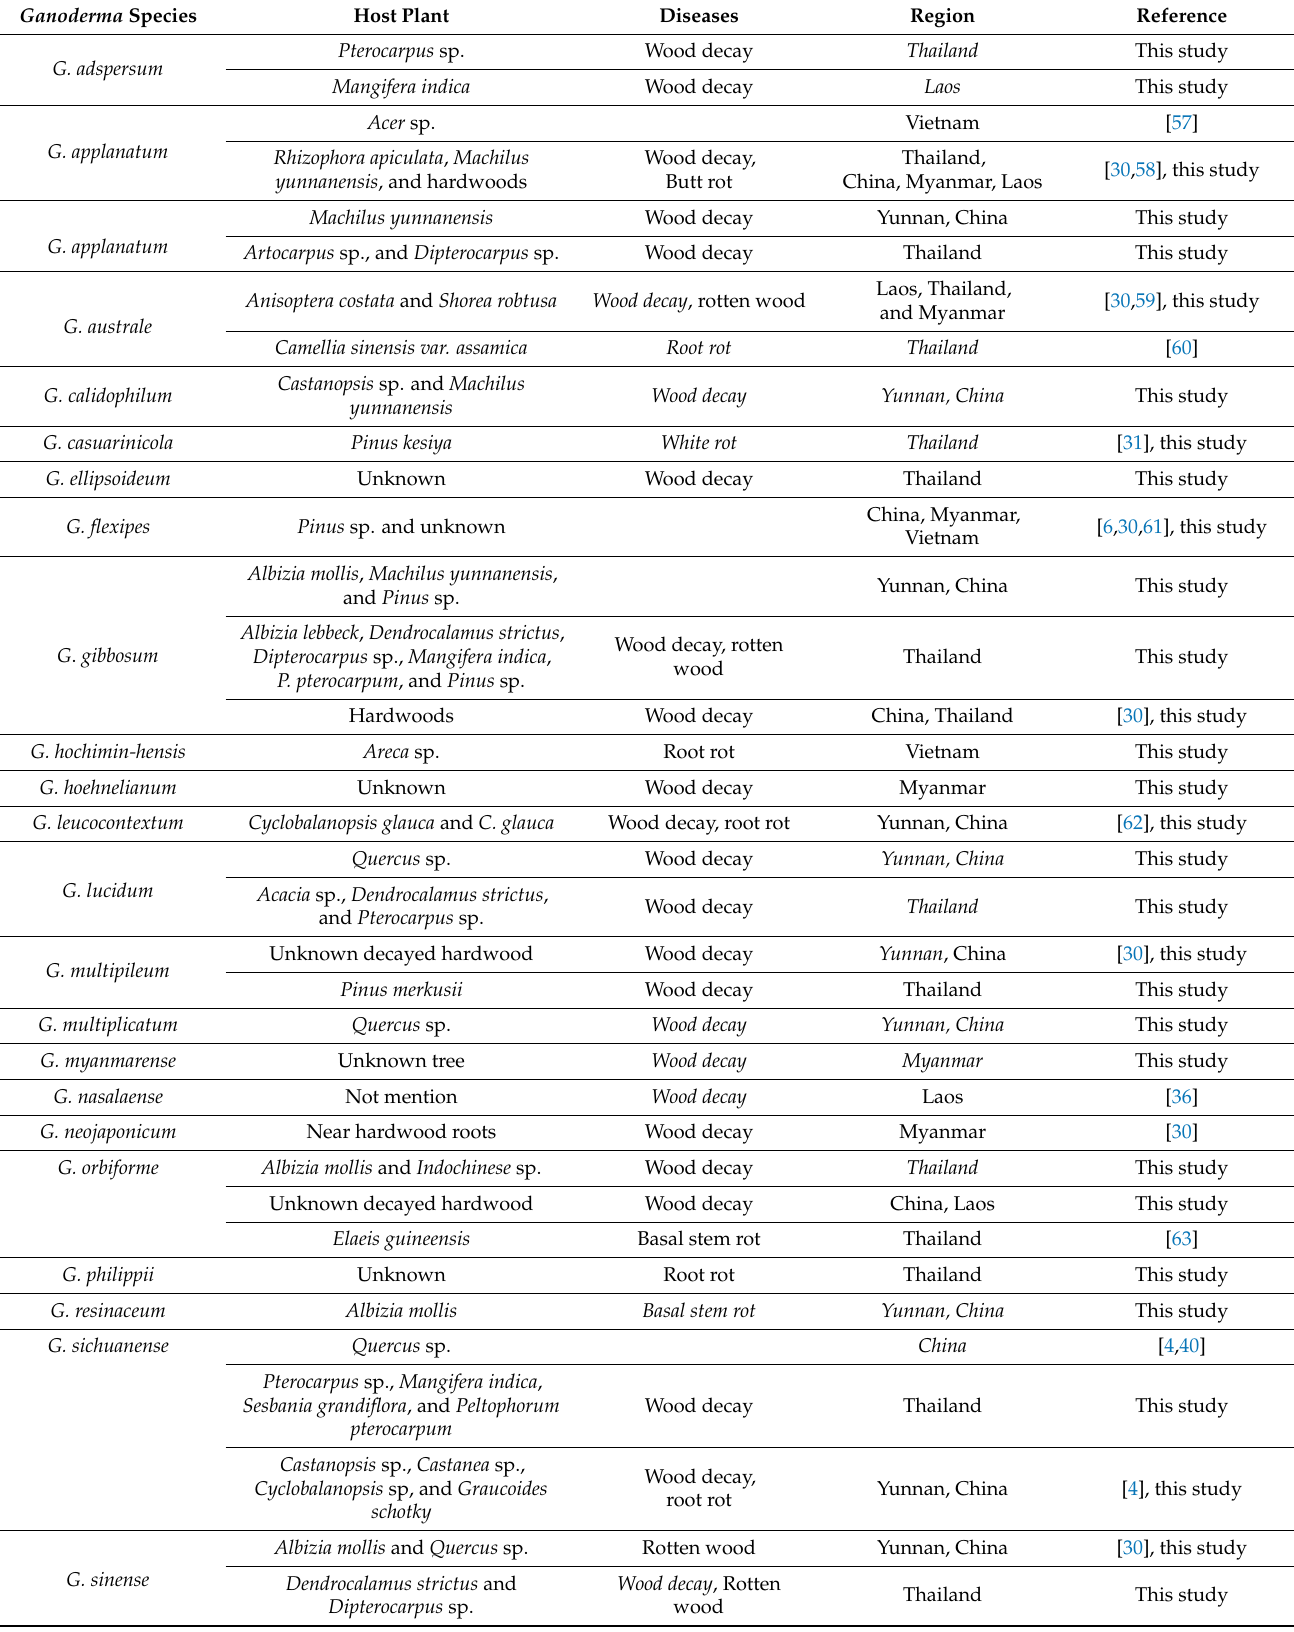
Table 1. Species of Ganoderma , host plants, diseases, and main regions of distribution within the Greater Mekong Subregion. Ganoderma